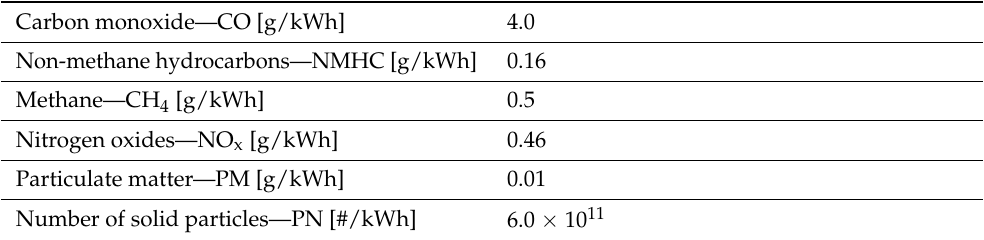
Table 1. The EURO VI pollutant emission limits for NG HD